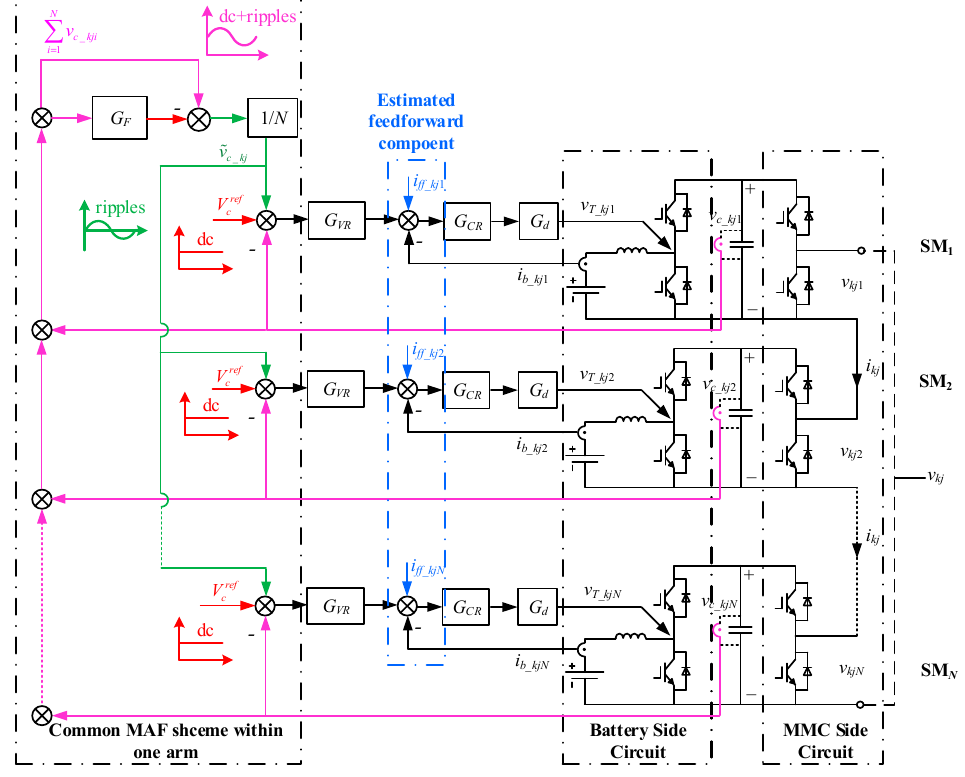
Figure 10. Capacitor voltages within one phase arm under unbalanced battery powers. ( a ) Unbalanced battery currents within phase arm. ( b ) Capacitor voltages within phase arm.